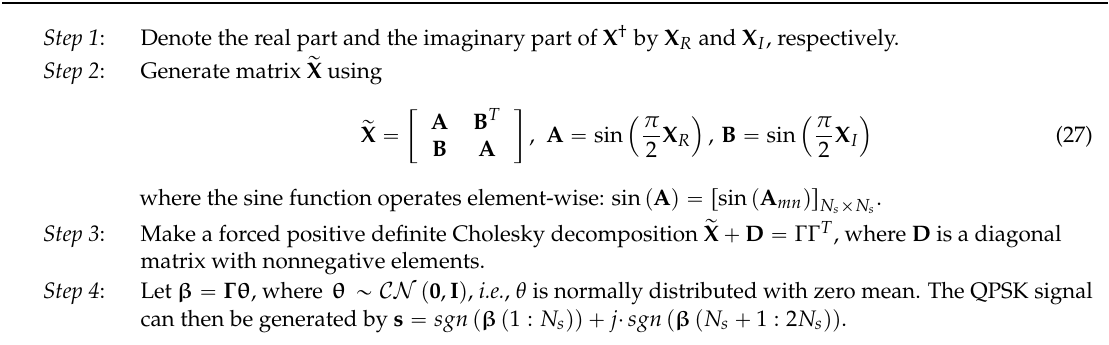
Table 3. Candidate quadrature phase-shift keying (QPSK) signal vectors design